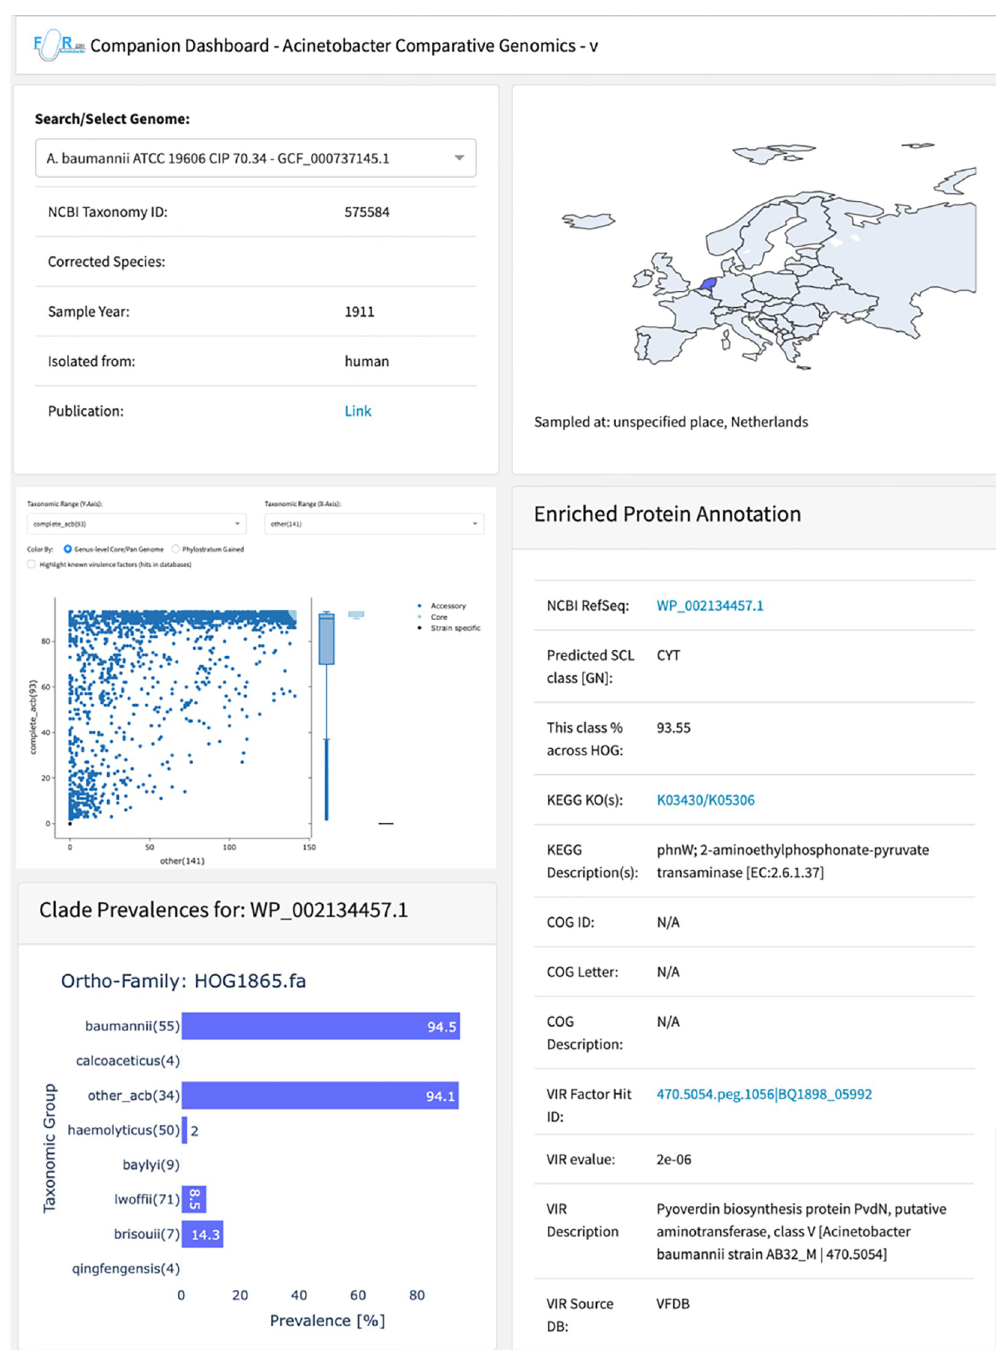
Fig 1. Aci-Dash–Interactive exploration of phylogenetic abundance patterns and accessory annotations for the Set-R pan-genome. For each of the 232 strains, Aci-Dash provides further details about year and site of sampling. The map was generated with Plotly for Python with a basemap from Natural Earth (https://www.naturalearthdata.com). The interactive scatter plot reveals, for each gene of the selected strain, the abundance of orthologs in a user-defined in- and outgroup. For each gene individually, the ortholog abundance can be resolved on a clade level (cf. Fig 2), and further information including functional annotation transfer from KEGG and COG as well as known virulence factors is displayed.